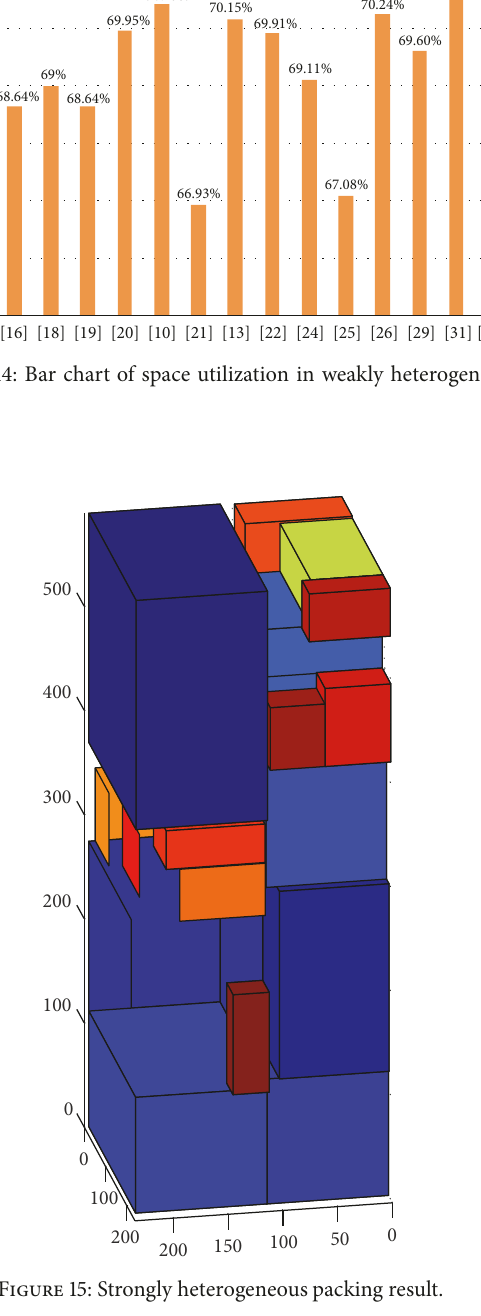
Table 6: The test data of strongly heterogeneous